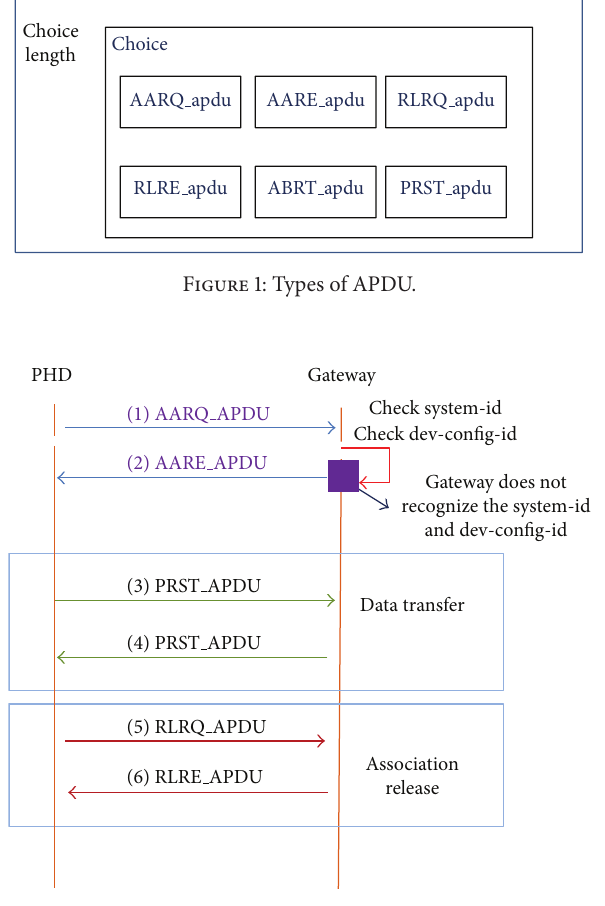
Figure 2: ISO/IEEE 11073-20601 communication